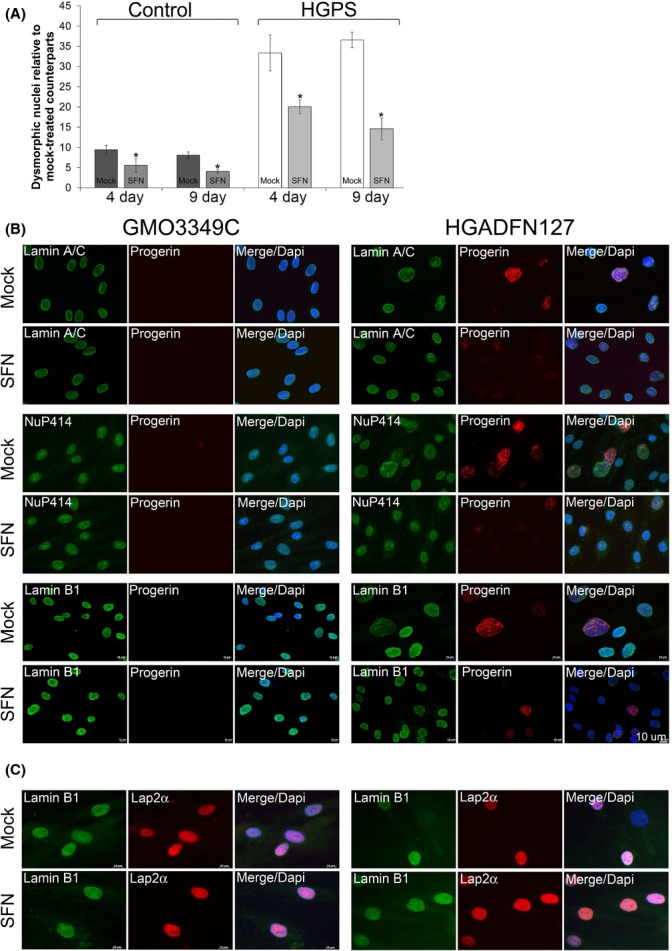
The effect of sulforaphane (SFN) on the distribution of progerin and nuclear proteins in normal and HGPS fibroblasts. (A) Frequency of misshapen nuclei (dysmorphic) in three control and three HGPS fibroblast lines after 4 or 9 days of treatment with either vehicle or SFN (1 μm). The bars indicate the mean frequency of misshapen nuclei. An average of 800 nuclei were examined for each control and HGPS cell line, and treatment, and each experiment was repeated three times. (B) Immunocytochemistry using antibodies directed against the indicated proteins (progerin, lamin A/C, a nuclear pore proteins (Nup414), and lamin B1) was performed on normal (GMO3349C) and HGPS (HGADFN127) cells mock-treated or SFN-treated cells for a period of 9 days. (C) The same cells and conditions as in (A) were immunolabeled with anti-LAP2α and anti-lamin B1 antibodies. Scale bar: 10 μm.